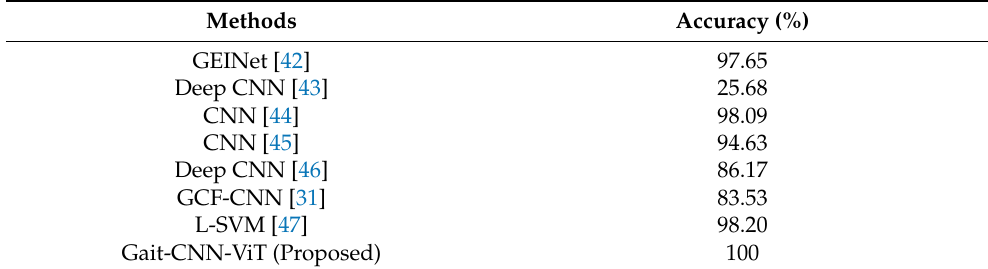
Table 3. Comparison results on the CASIA-B dataset.